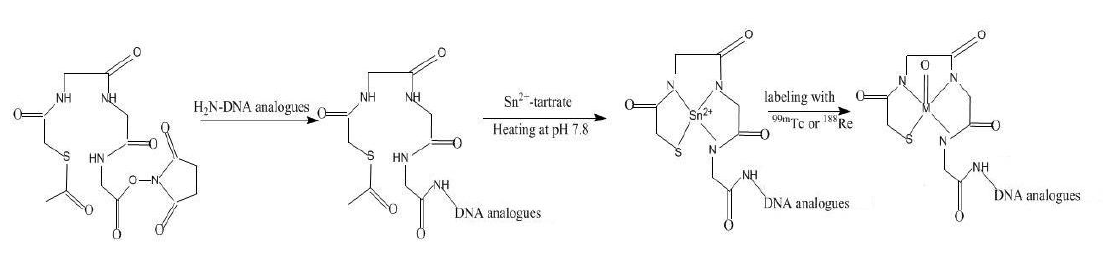
to amine-derivatized oligomers, and 3